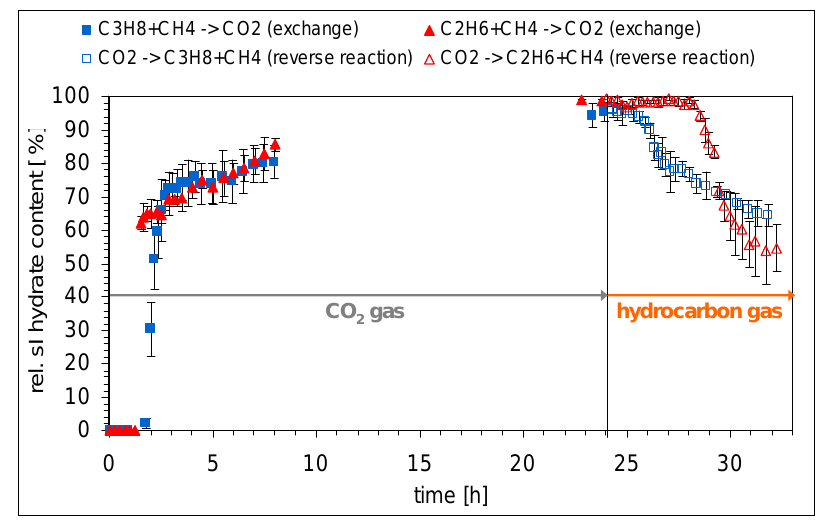
Figure 6. Transformation of CH structure II mixed hydrate into a CO reverse